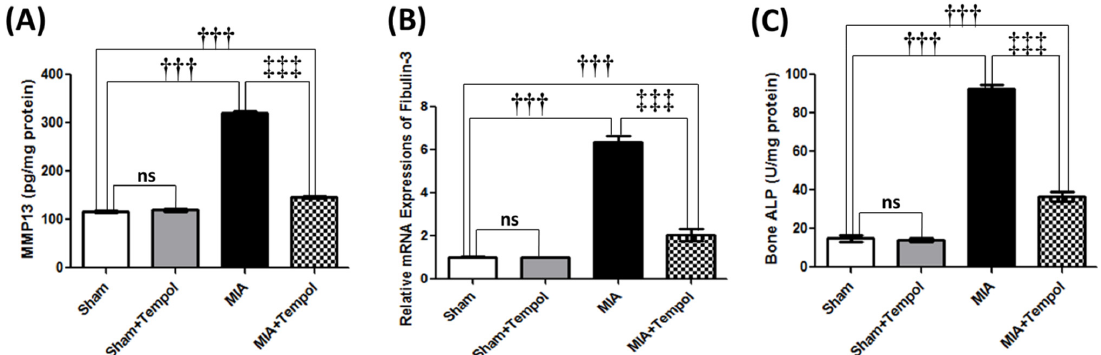
Figure 3. Effect of Tempol on knee joint degradation-related biomarkers on osteoarthiritic rats. Rats were subjected to a single intra-articular injection of 3 mg MIA/50 μ L saline in their right knees, and then tempol was administered starting from the 7th day of the experiment in a dose of (100 mg/kg/day) by oral gavage for 21 consecutive days. Values of ( A ) Tissue contents of metalloproteinase-13 (MMP-13), ( B ) The mRNA expression of fibulin-3, and ( C ) Tissue contents of bone alkaline phosphatase (ALP). Statistical analysis was carried out using one-way ANOVA followed by Tukey’s multiple comparison test. Results are expressed as mean ± SD ( n = 6). ††† p < 0.001 vs. the sham group, and ‡‡‡ p < 0.001 vs. MIA group.